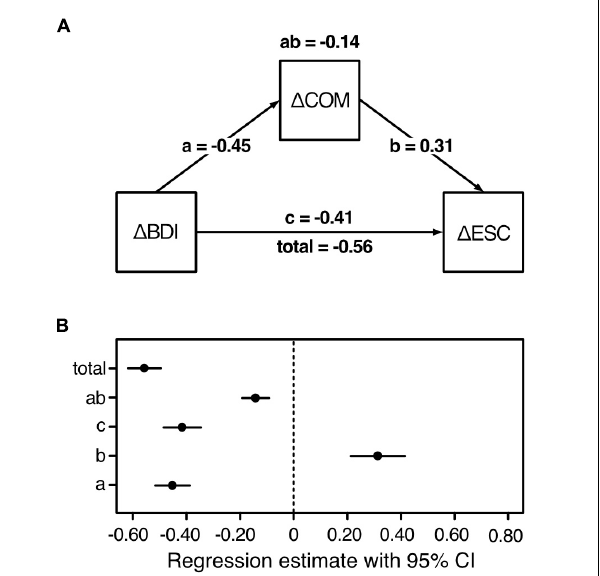
FIGURE 5 | Results and model of the mediation analysis in the second sample ( n 2 = 468). BDI, depressive symptoms; COM, cognitive motivation; ESC, effortful self-control; (cid:49) , latent change score (i.e., the change from t 1 to t 2 ). (A) Increasing cognitive motivation partially mediates the association between decreasing depressive symptoms and increasing self-regulation. The following unstandardized effects are displayed: total (direct effect without mediation) = ab (indirect mediating effect) + c (direct effect with mediator). (B) 95% confidence intervals of the unstandardized regression estimates, based on 1,000 bootstrap